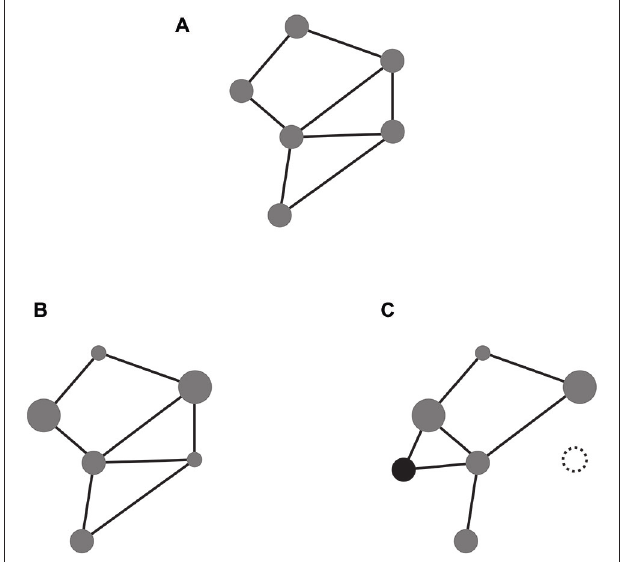
FIGURE 1 | (A) Feature compound with equal weights; (B) Same compound with different weights (indicated by node size); (C) Same compound with one of the original features deleted (dotted) and a novel feature included